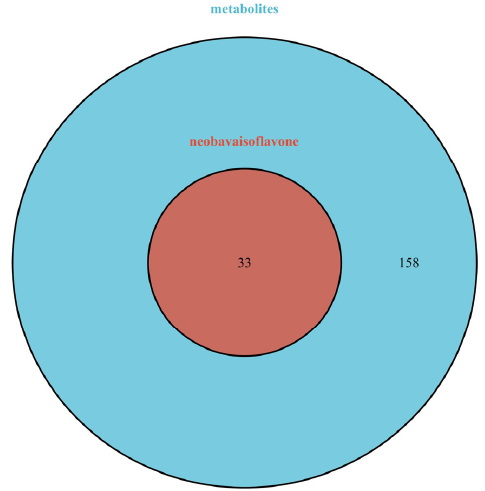
Figure 7. The ingredient-target network of neobavaisoflavone and its main metabolites, and the size was correlated to the degree of targets.